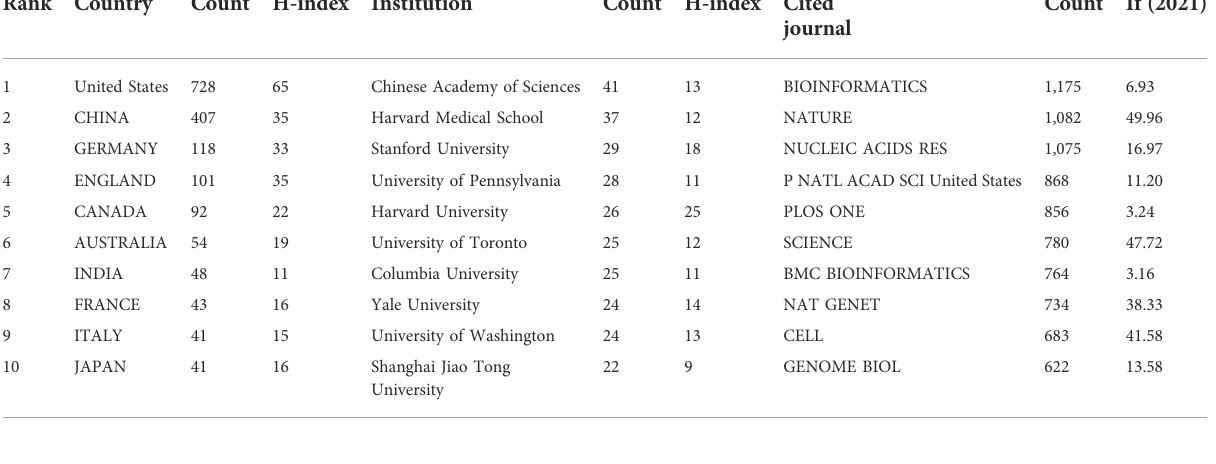
TABLE 1 Top 10 countries, institutions, and journals.